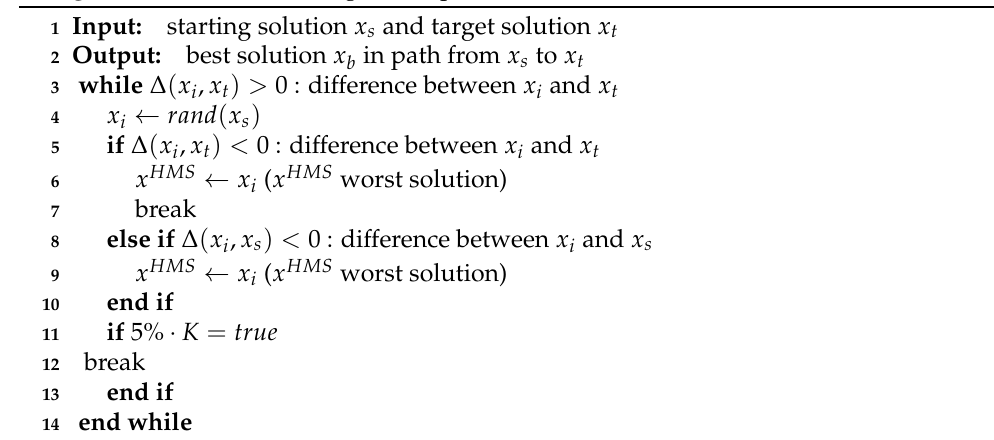
Algorithm 3: Path Relinking search process for new